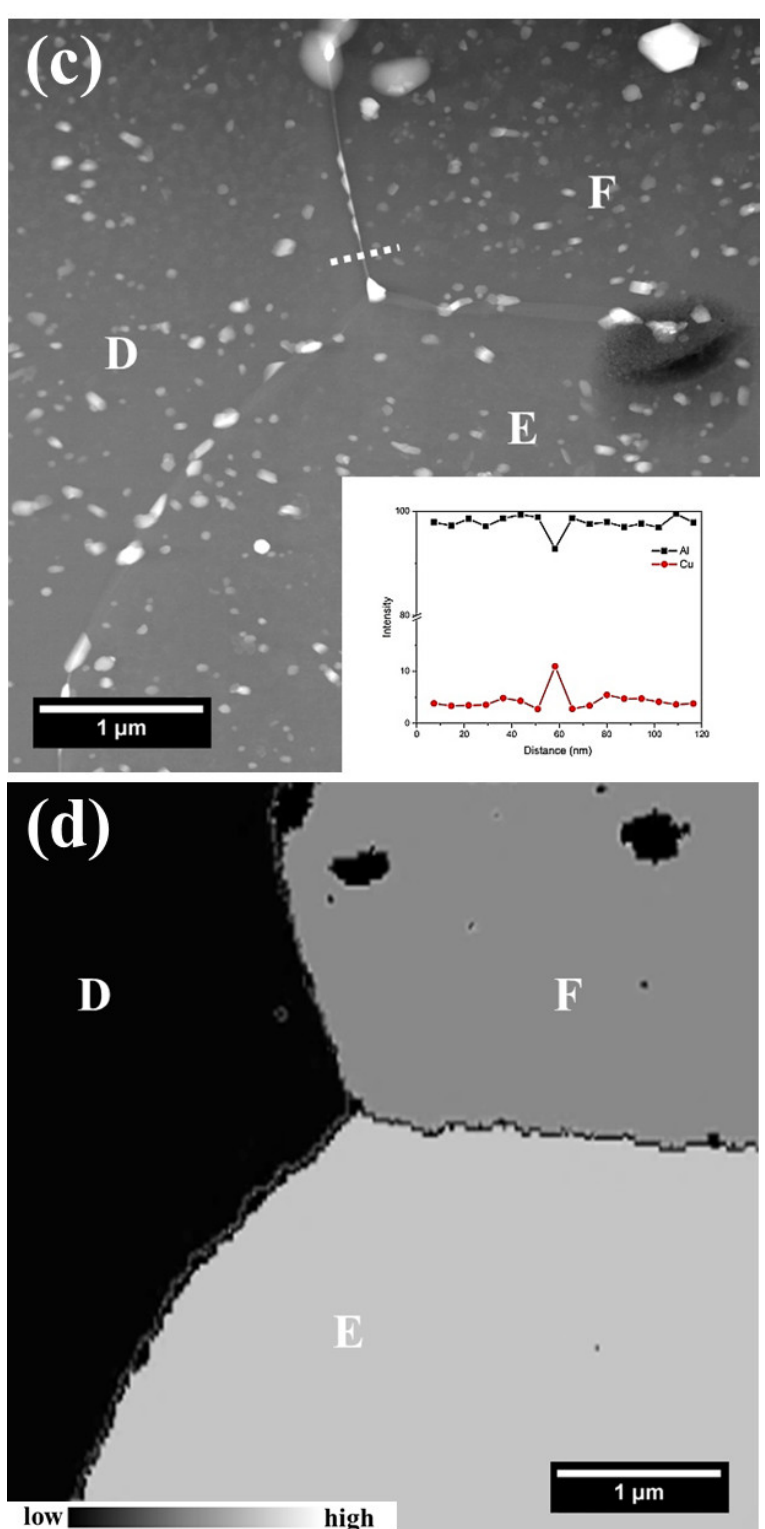
Figure 3. ( a ) High angle annular dark field (HAADF) micrograph of typical grain boundaries in AA2024‐T3 alloy with the elemental profile along the dashed line inset; ( b ) stored energy distribution of the framed area in ( a ); ( c ) HAADF micrograph of typical grain boundaries in the AA2024‐T3 alloy; ( d ) the corresponding stored energy distribution of ( c ).